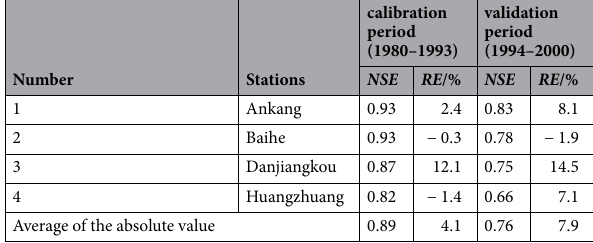
Table 5. Calibration and validation results of the SWAT